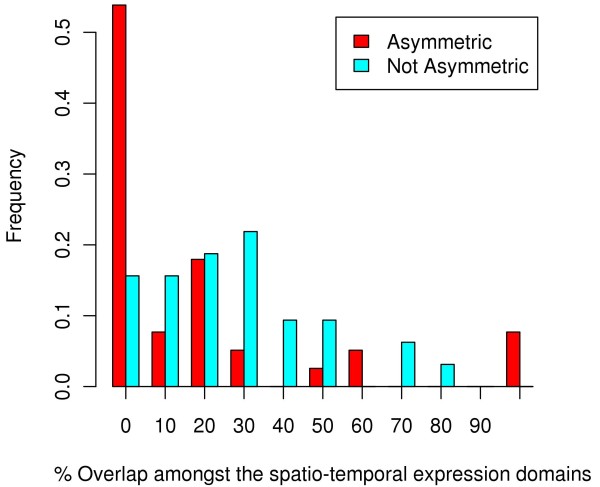
Distribution of the normalized overlap between the spatio-temporal expression domains for asymmetrically and non-asymmetrically evolvingD. reriogene duplicates computed separately at every developmental stage.